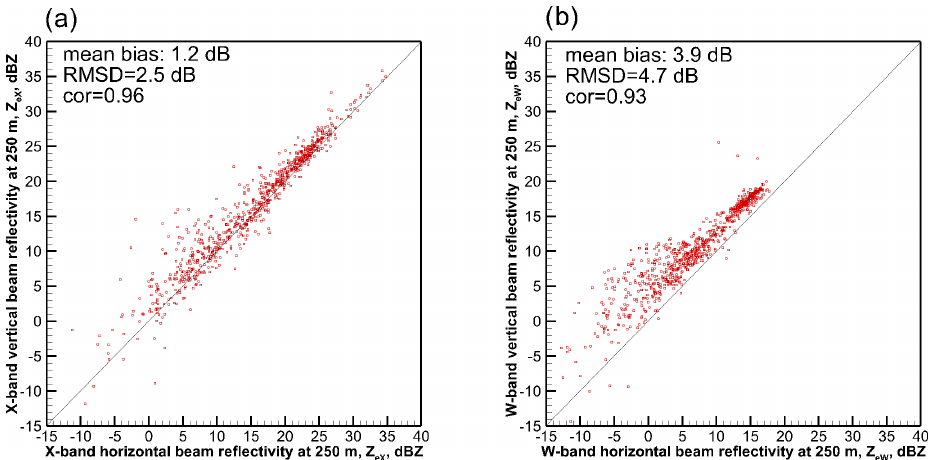
Figure 5. Scatter plots of observed 250m horizontal and vertical pointing reflectivities for (a) X-band and (b) W-band